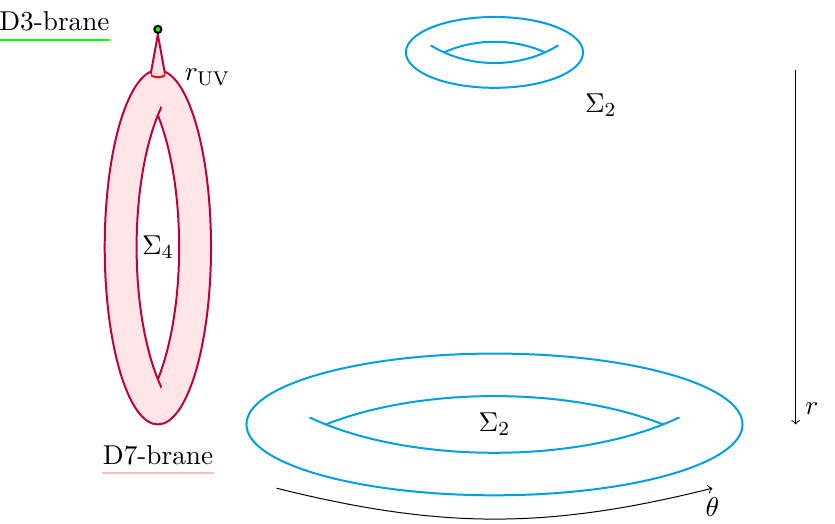
Figure 1 . A sketch of the toy configuration under consideration, with the D7-brane wrapping the 4-space at θ = 0 and some throat being glued to the bulk at r = r UV . The D3- or anti-D3-brane provides extra open-string states, as discussed in sections 3 and 4,